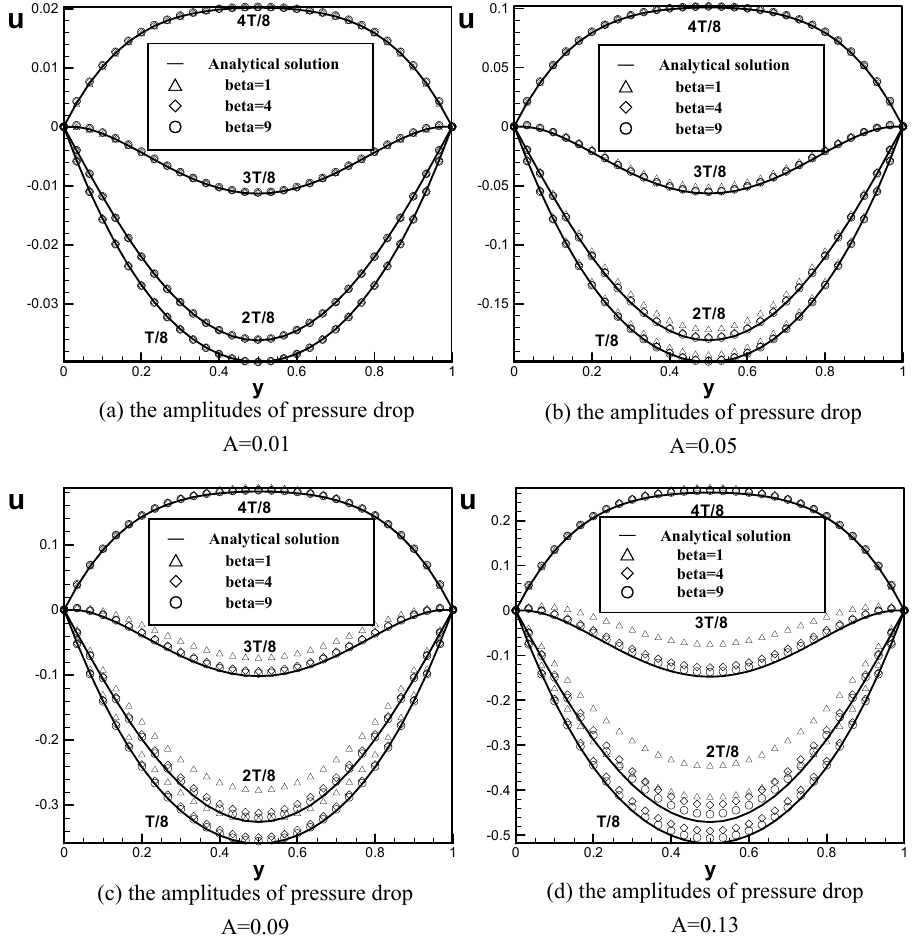
Fig.4 The velocity profiles in Womersley flow at the middle of the channel at four time moments for different